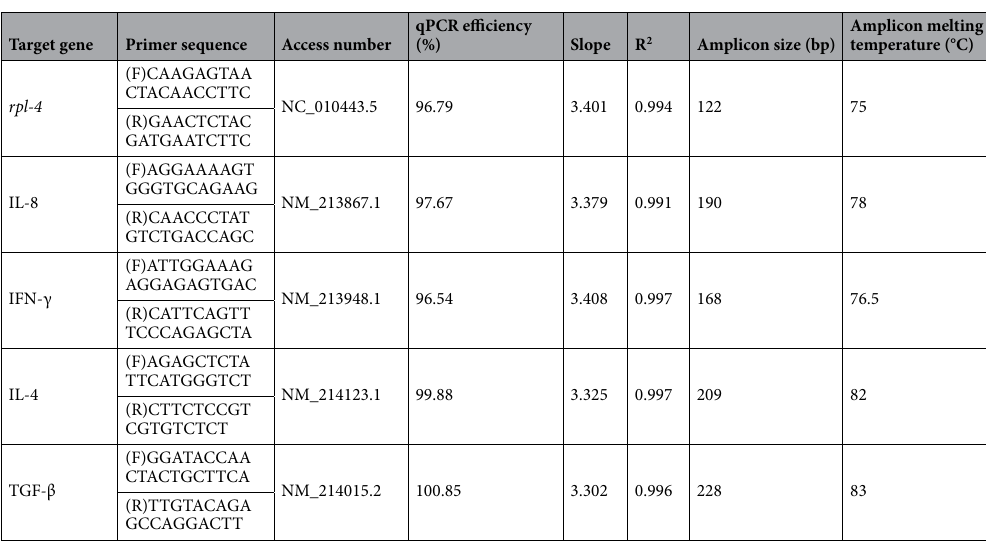
Table 3. Details of the primer sequences of cytokines used for quantitative SYBR Green real-time PCR amplification. The rpl-4 gene was used as